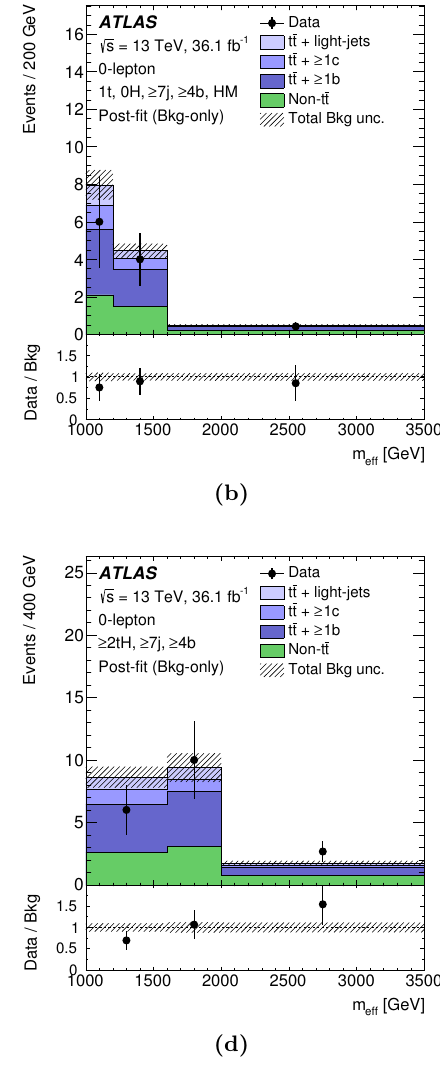
Figure 13. Comparison between the data and prediction for the m e(cid:11) distribution in some of the most sensitive search regions in the 0-lepton channel, before and after performing the combined (cid:12)t to data in the 0-lepton and 1-lepton channels (\Pre-(cid:12)t" and \Post-(cid:12)t", respectively) under the background-only hypothesis. Shown are the (1t, 0H, 7j, 4b, HM) region (a) pre-(cid:12)t and (b) post- (cid:21) (cid:21) (cid:12)t, and the ( 2tH, 7j, 4b) region (c) pre-(cid:12)t and (d) post-(cid:12)t. In the pre-(cid:12)t (cid:12)gures the expected (cid:21) (cid:21) (cid:21) T (cid:22) T signal (solid red) corresponding to m T = 1 TeV in the T doublet scenario is also shown, added on top of the background prediction. The small contributions from t (cid:22) tV , t (cid:22) tH , single-top, W=Z +jets, diboson, and multijet backgrounds are combined into a single background source referred to as \Non- t (cid:22) t ". The last bin in all (cid:12)gures contains the over(cid:13)ow. The bottom panels display the ratios of data to the total background prediction (\Bkg"). The hashed area represents the total uncertainty of the background. In the case of the pre-(cid:12)t background uncertainty, the normalisation uncertainty of the t (cid:22) t + 1 b background is not (cid:21)